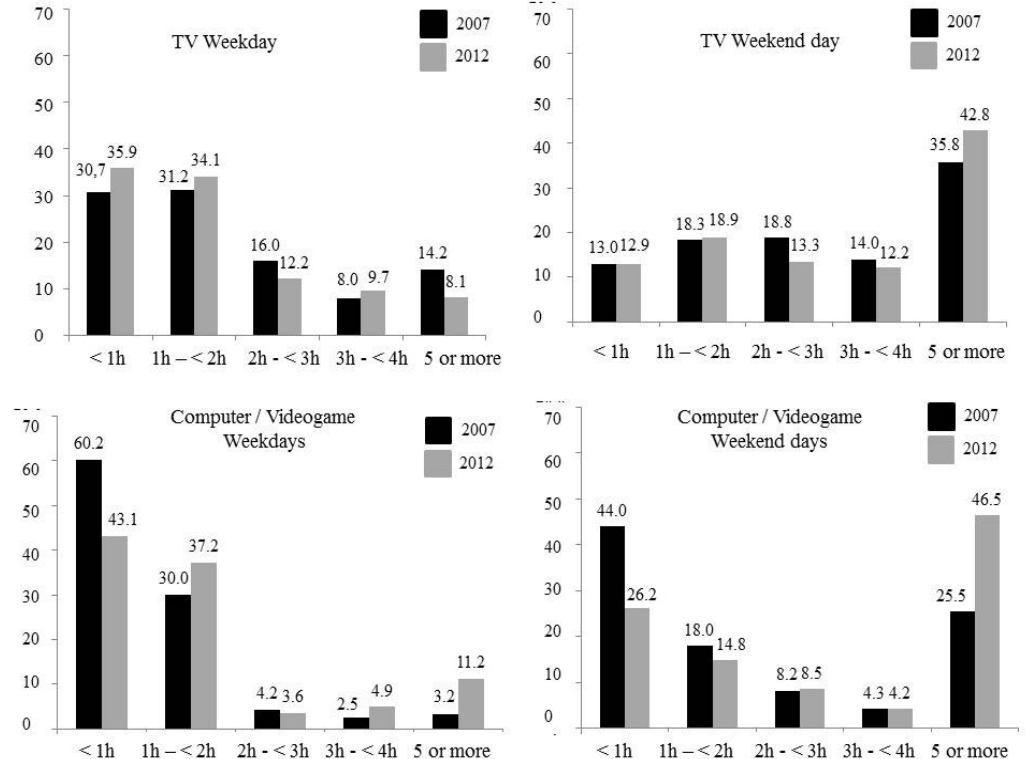
Figure 2. Time of use of TV, PC and VG, on weekdays, and weekend days, stratified by year (2007 and 2012).